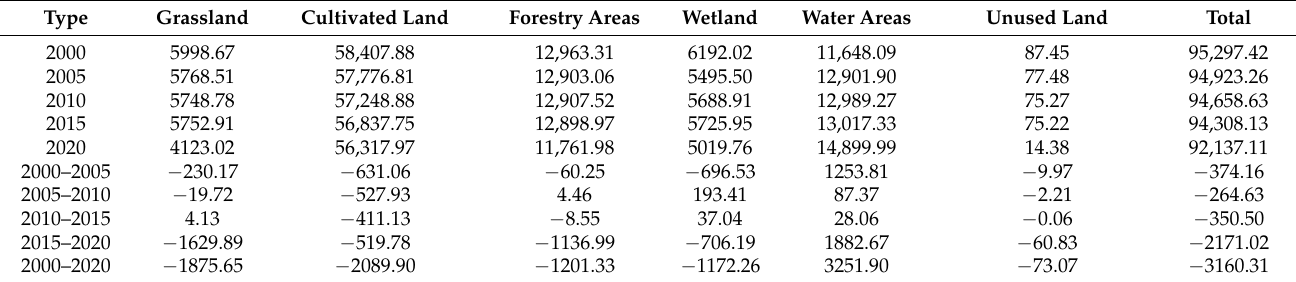
Table 5. ESVs of all land use types in the RAER from 2000 to 2020 (million yuan).